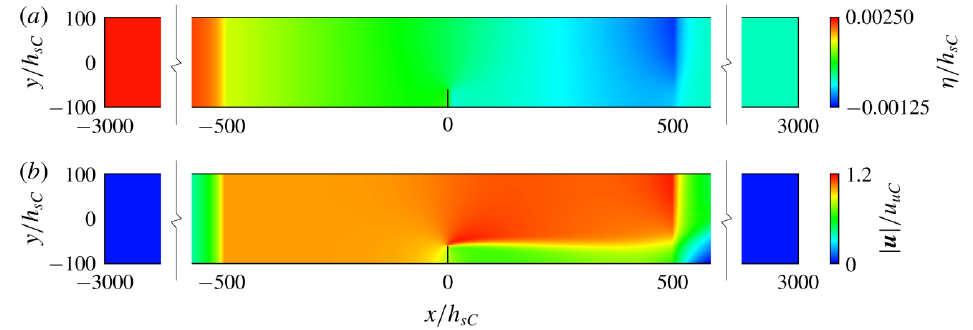
Fig. 8. Solution of the shallow water equations, calculated by Bonar et al. The unsteady elevation rise (a) and velocity drop in (b) indicate the presence of a hydraulic jump (from [7]).